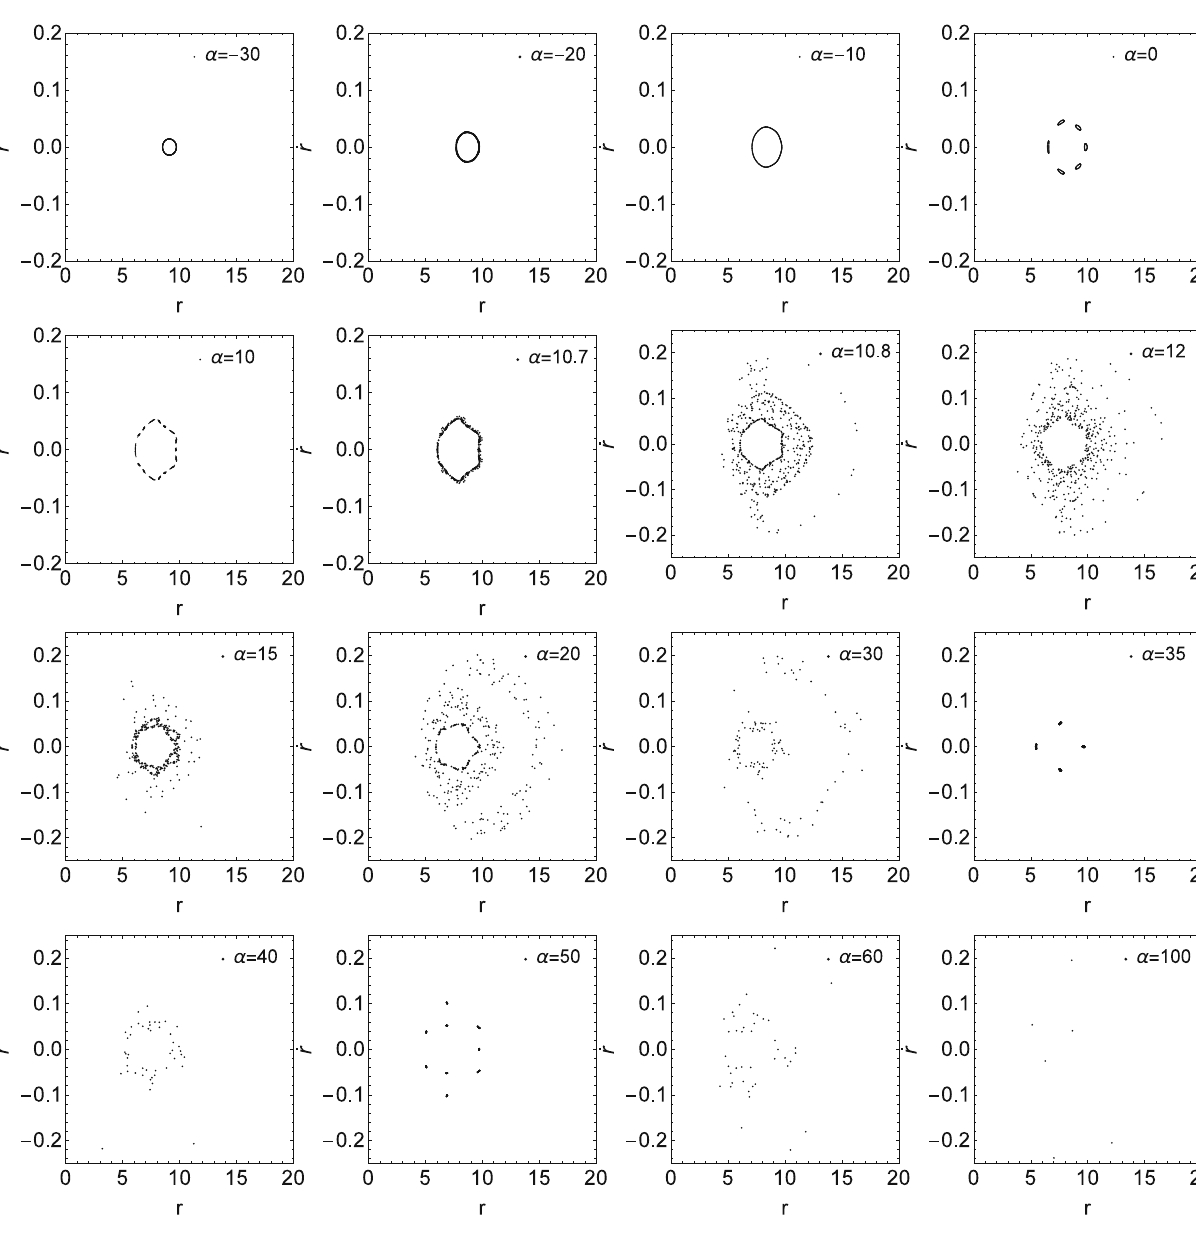
)withdifferentcouplingparameter α andfixed B = 0 . 02.Theinitialconditionsaresetas r ( 0 ) = 9 . 7, 2